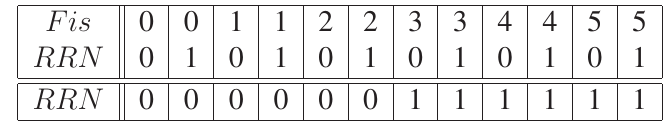
Figure 5: State transition table defining stable RNA behaviour.